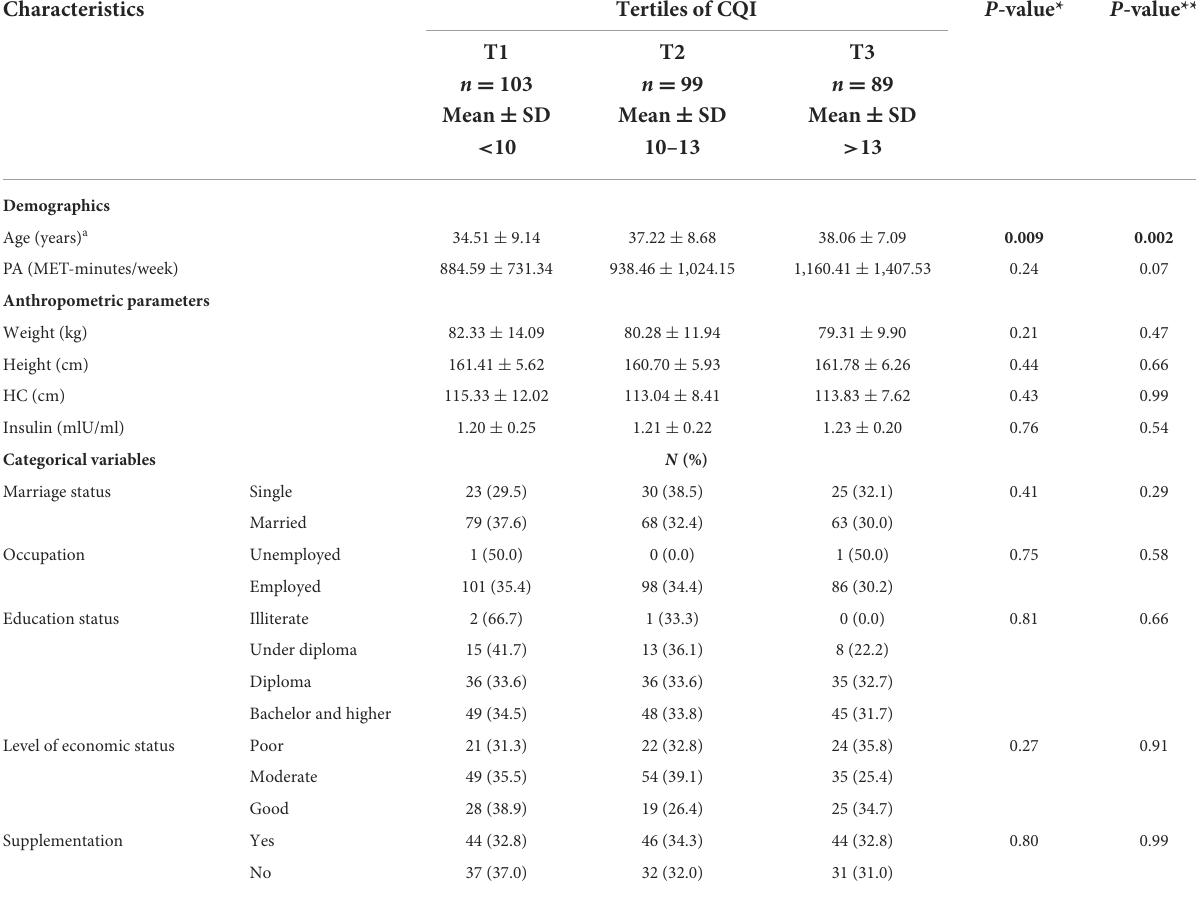
TABLE 2 General characteristics of study participants among tertiles of the CQI ( n = 291).